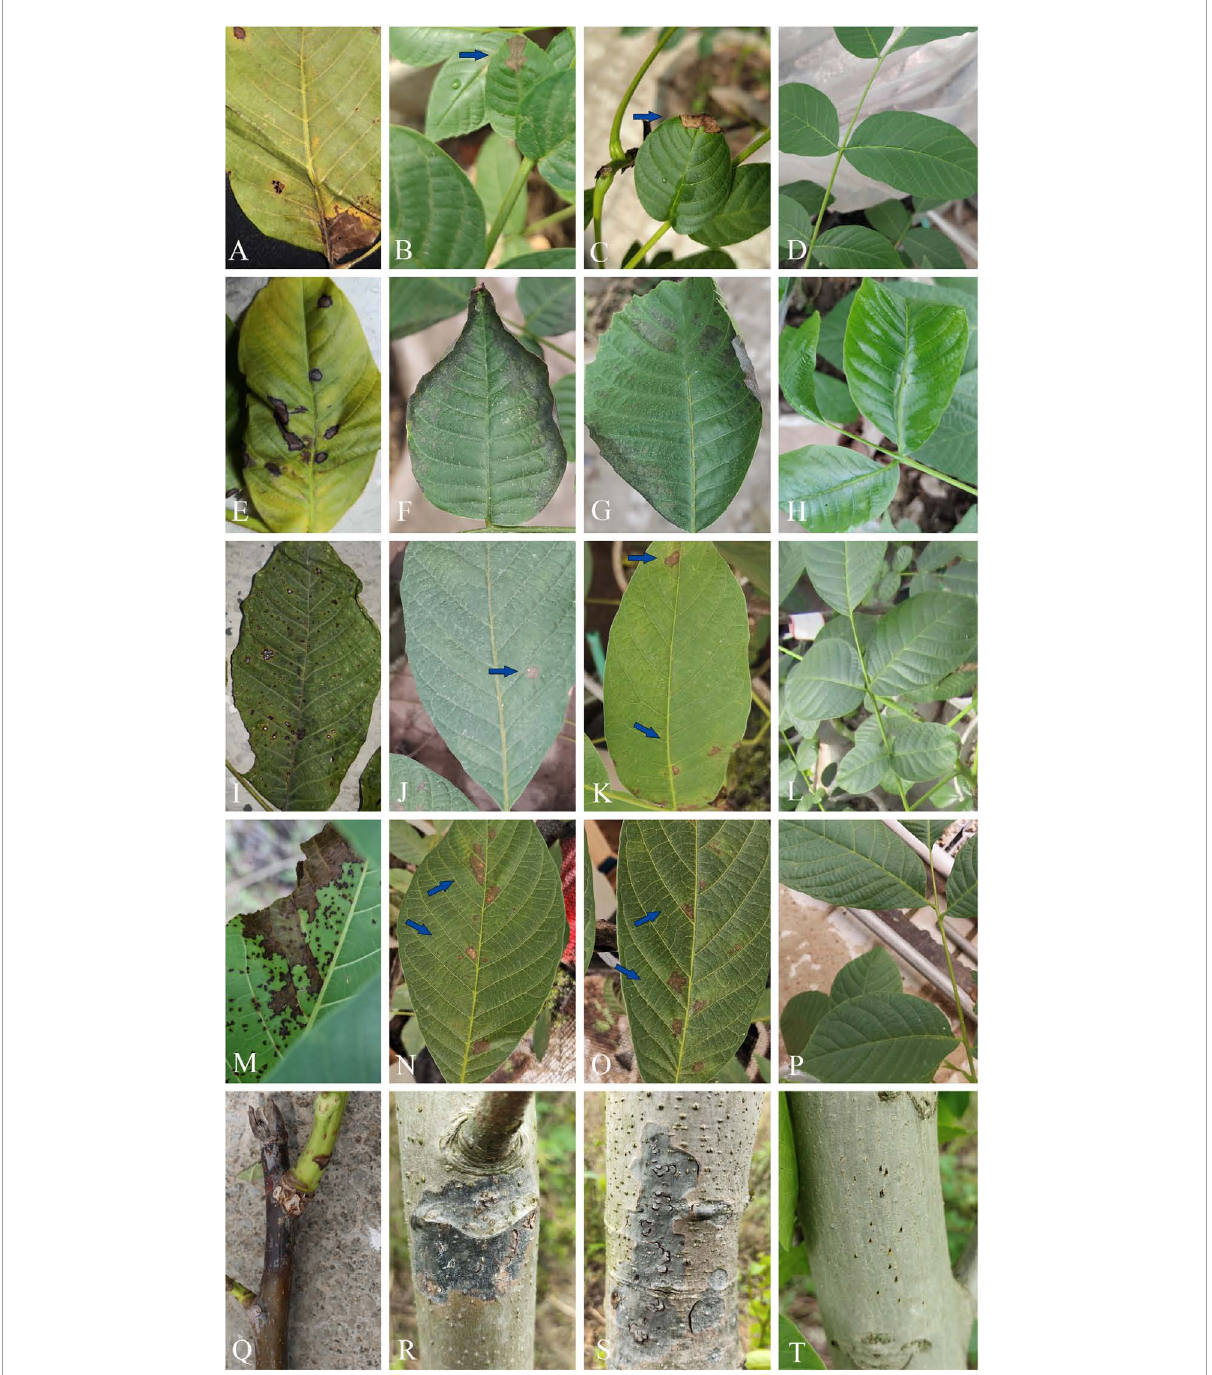
FIGURE12 Leaf spot and stem blight symptoms on Juglans regia caused by pathogenic fungi. (A–D) Leaf necrosis symptoms caused by Cladosporium tenuissimum (SICAUCC 22-0110): (A) Typical symptoms in natural state and (B) necrotic lesions (blue arrow) after 20 days of inoculation. (E–H) Leaf necrosis symptoms caused by Ophiognomonia leptostyla (SICAUCC 22-0103): (E) Typical symptoms in natural state and (F,G) necrotic lesions after 15 days of inoculation. (I–L) Leaf necrosis symptoms caused by Periconia byssoides (SICAUCC 22-0107): (I) Typical symptoms in natural state and (J,K) necrotic lesions (blue arrow) after 25 days of inoculation. (M–P) Leaf necrosis symptoms caused by Sphaerulina juglandina (SICAUCC 22-0108): (M) Typical symptoms in natural state and (N,O) necrotic lesions (blue arrow) after 25 days of inoculation. (Q–T) Blight symptoms caused by Neofusicoccum sichuanense (SICAUCC 22-0094): (Q) Typical symptoms in twigs in natural state and (R,S) stem blight symptoms after 40 days of inoculation. (D,H,L,P,T) Blank control group, no symptoms on leaves and stems after 25 days of